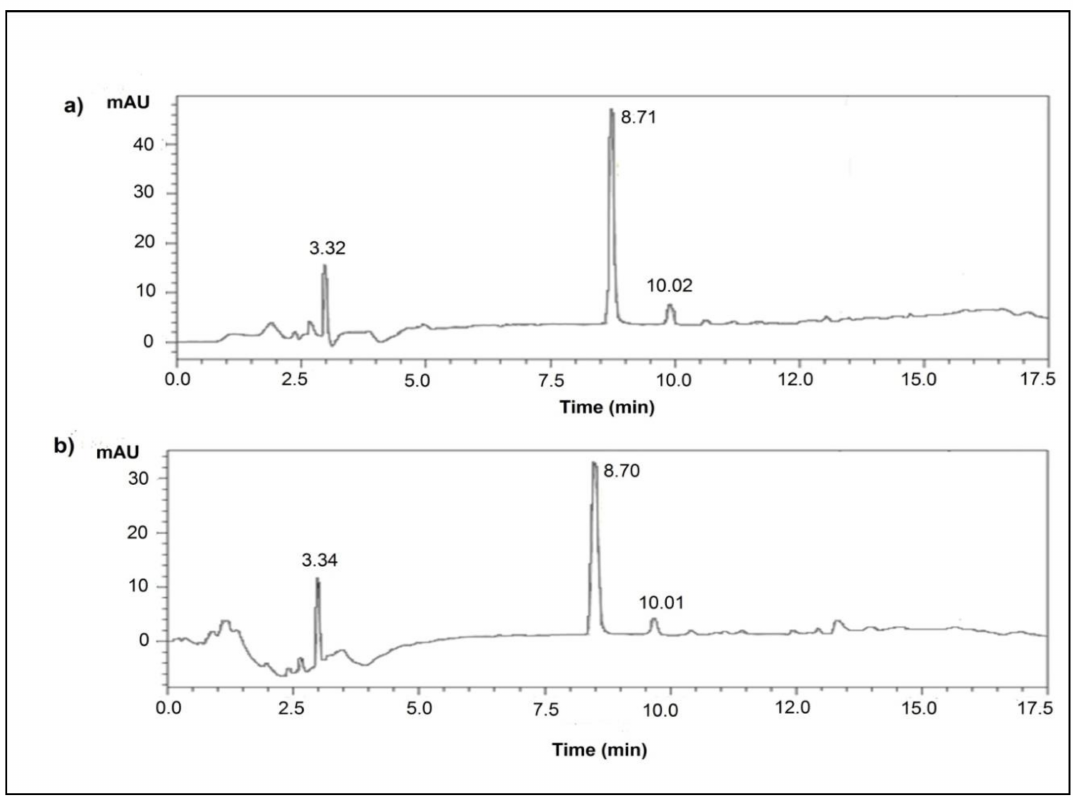
Figure 6. RP-HPLC-PDA chromatograms of the aqueous samples, where ( a ) is standard L-alanine and ( b ) is L-alanine produced by the recombinant strain. Analysis was performed using a C 18 column (250 × 4.6 mm) with a column particle size of 10 µ m, mobile phase (sodium acetate and acetonitrile) at a flow rate of 1.0 mL/min, a detection wavelength of λ = 250 nm and a 10 µ L injection volume. Presence of a sharp peak at a retention time of 8.7 min in the ( a ) standard chromatogram and ( b ) chromatogram of the test sample confirms the presence of L-alanine in the crystals, wherein the minor peaks at RTs 3.3 and 10.0 min may signify the contaminant amino acids, such as L-glutamic acid and L-phenylalanine,